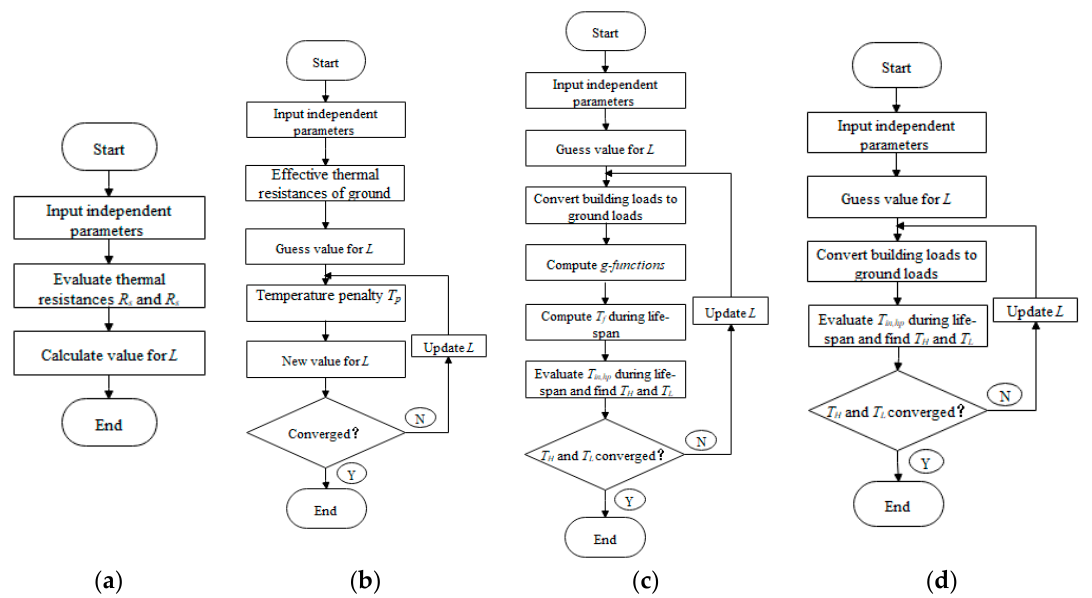
Figure 7. Flowcharts of the typical steps required to size a BHE bore field for different sizing methods: ( a ) M1, ( b ) M2, ( c ) M3, and ( d ) M4.